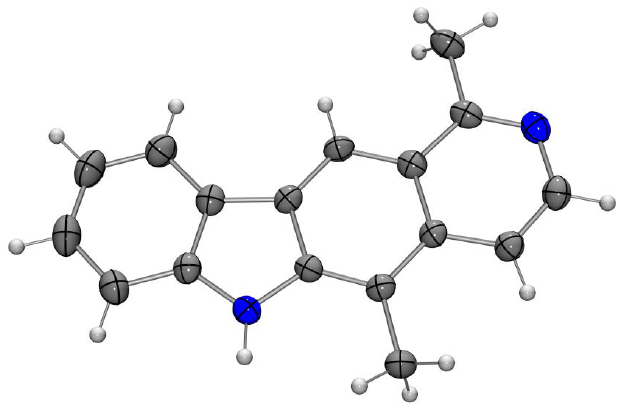
Figure 3. Molecular structure of olivacine ( 1 ) in the crystal (ORTEP plot showing thermal ellipsoids at the 50% probability level).